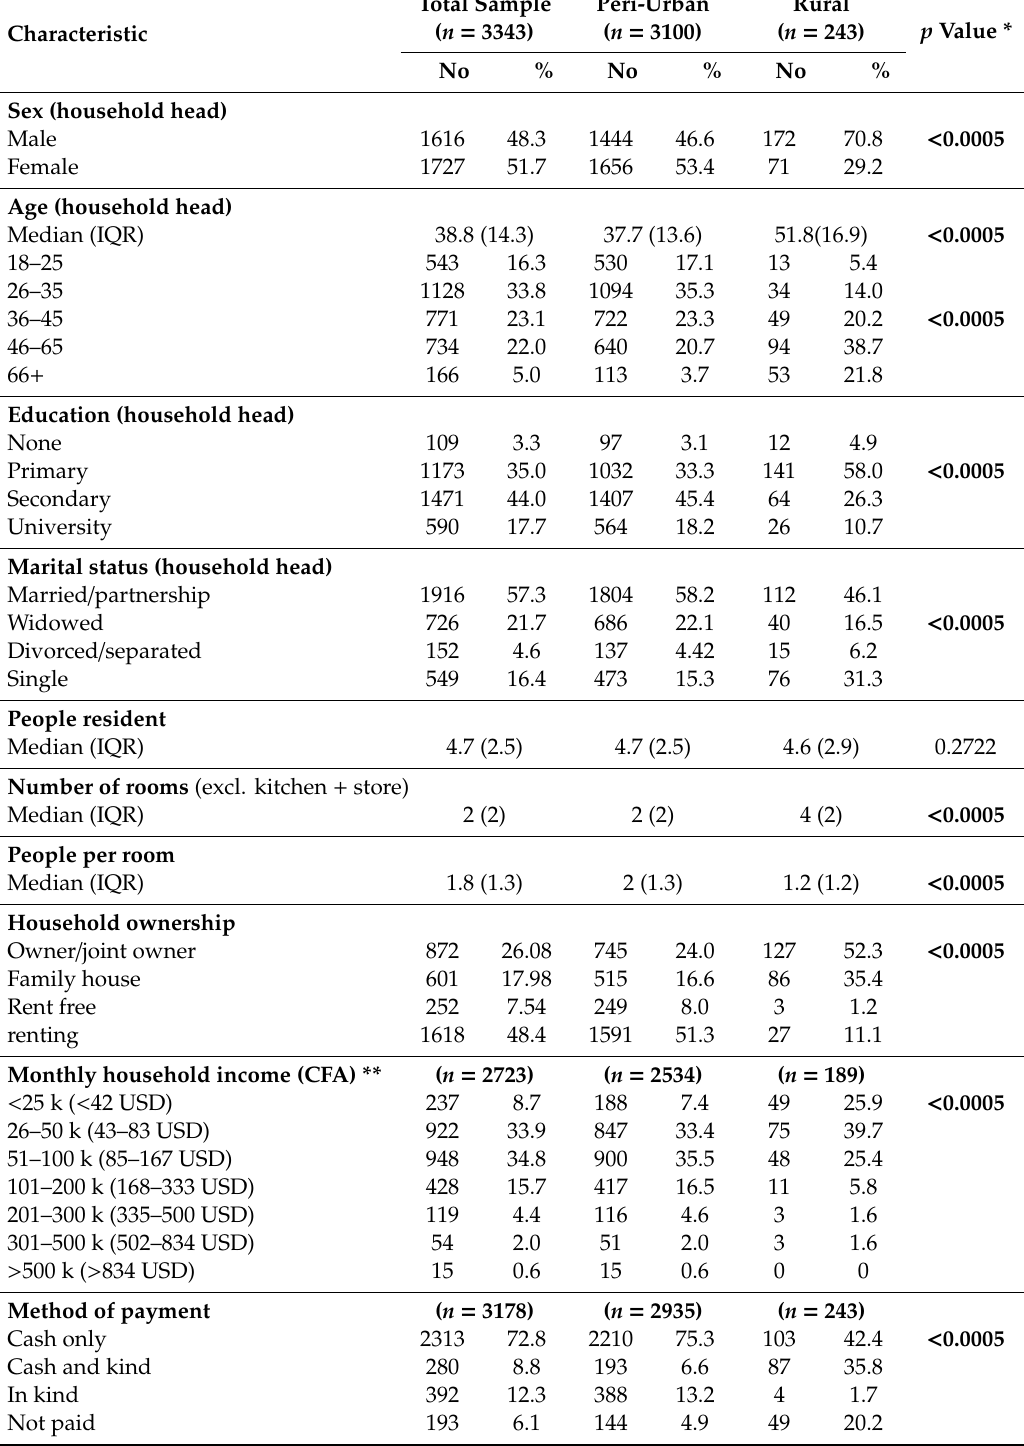
Table 3. Characteristics of the households and household heads in the whole sample and stratified by rural and peri-urban